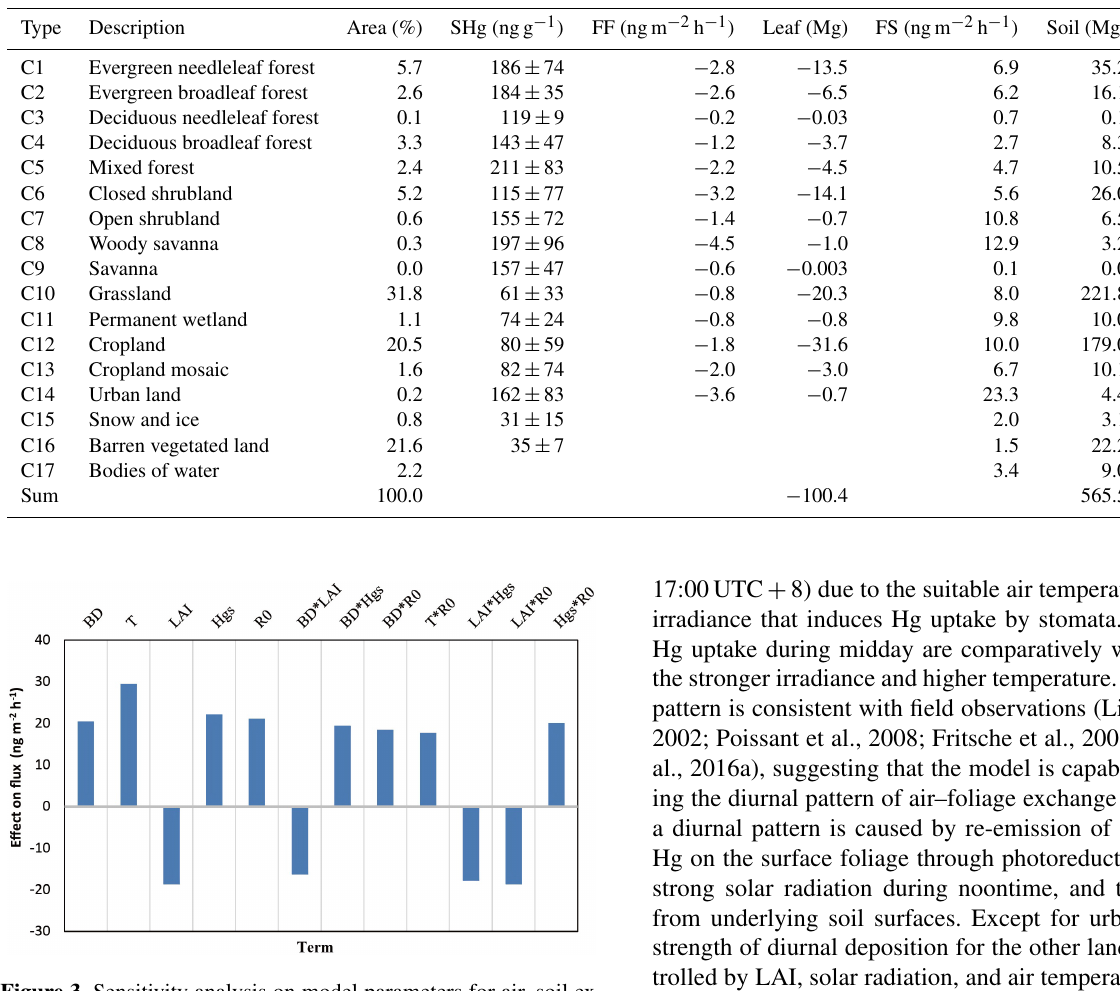
Figure 3. Sensitivity analysis on model parameters for air–soil ex- change using a two-level factorial design after prescreening the model variables shown in Table 2 for the identified significant fac- tors. The effects shown in the figure are based on a significance level of 95% (i.e., p <